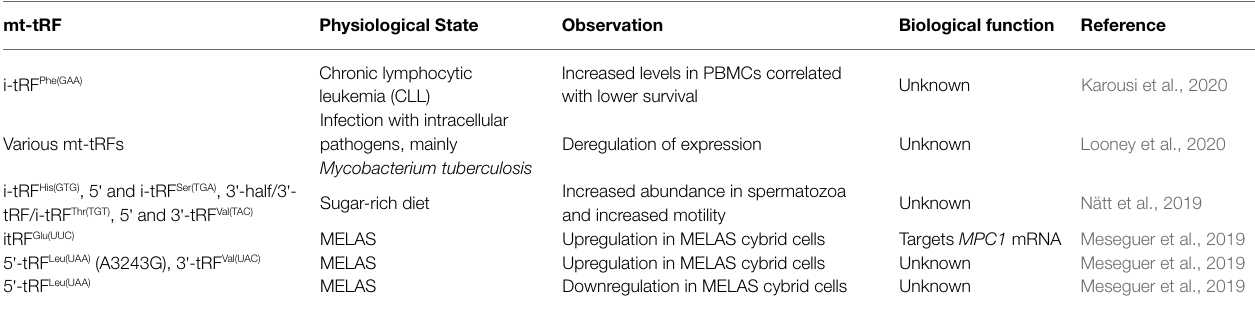
TABLE 1 | Examples of mitochondrial tRNA fragments affected under various conditions.